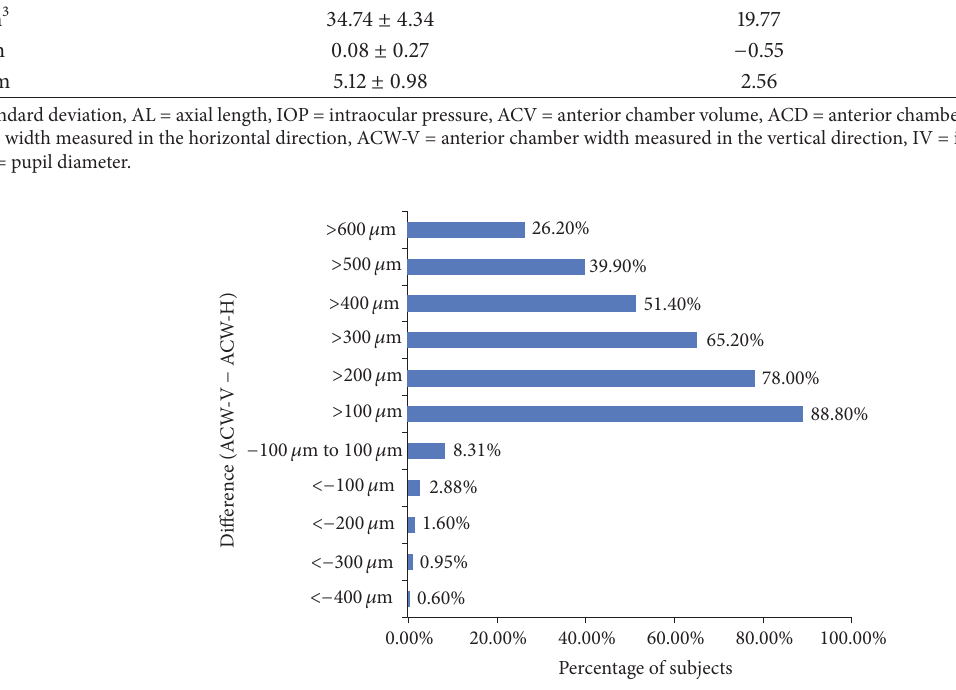
Figure 1: Differences in the anterior chamber width measured on horizontal and vertical